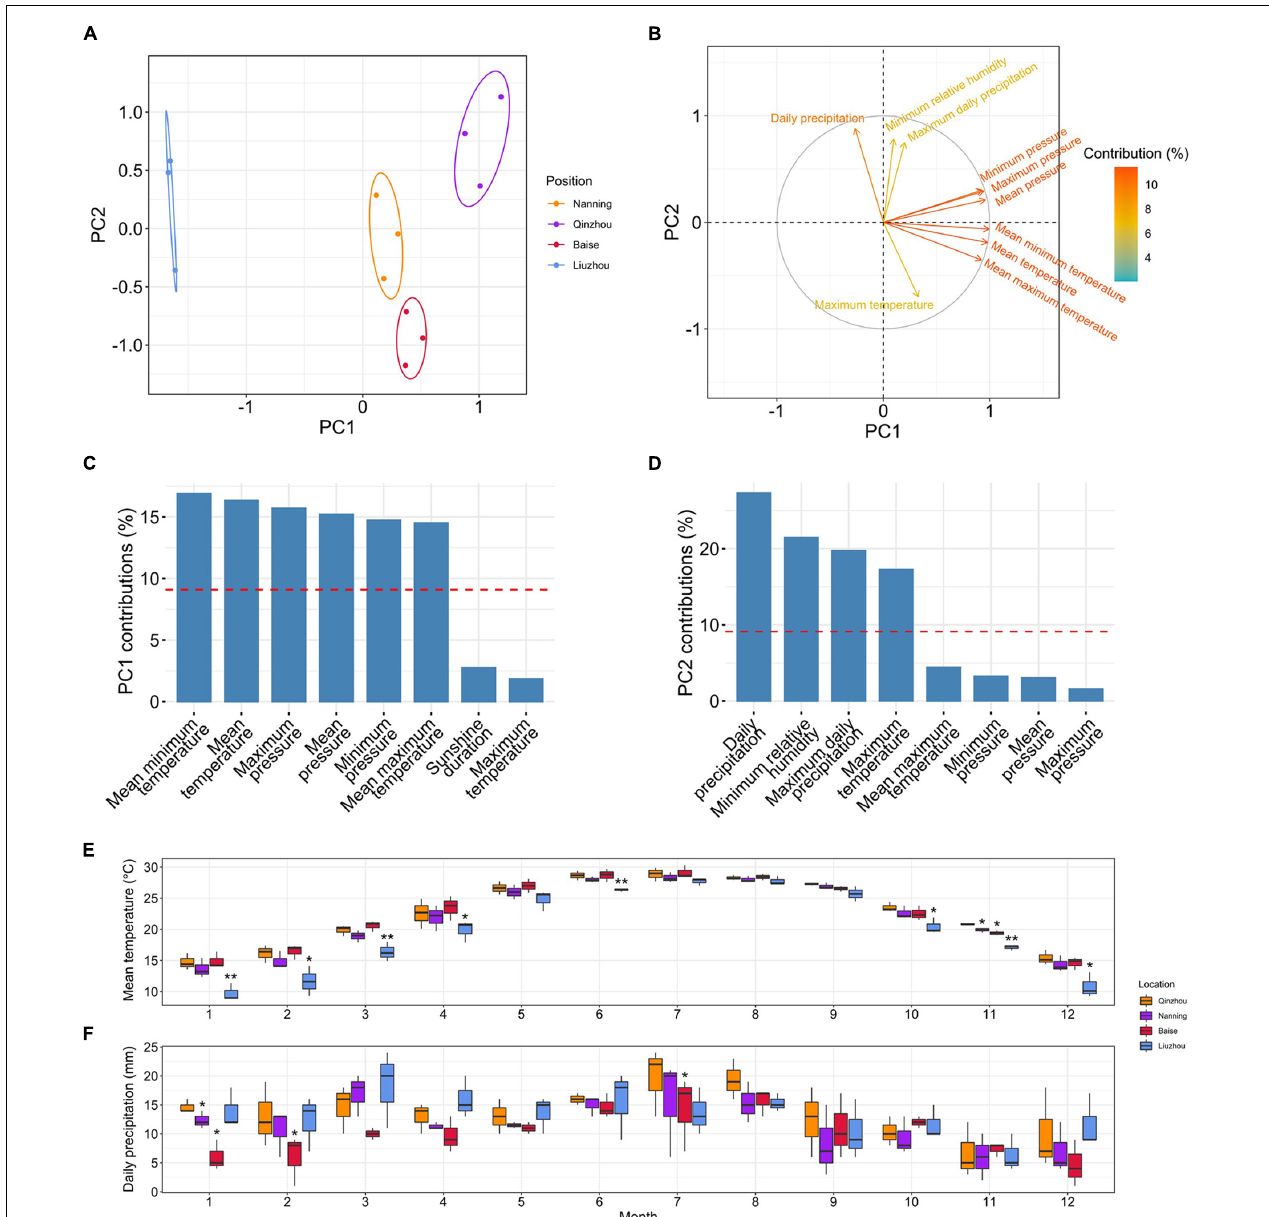
FIGURE 7 | Analyses of climatic factors in different planting locations. (A) Principal component analyses (PCA) of seventeen climatic factors in the four planting locations in 2018, 2019, and 2020. (B) The loadings of climatic factors in the PCA plot. The colors of the arrows represent the percentages of the contributions of climatic factors to the PCs. (C) Histograms of the percentages of the contributions of different climatic factors to PC1. The red dashed lines indicate the average contributions of different climatic factors. Only the top eight climatic factors are shown. (D) Histograms of the percentages of the contributions of different climatic factors to PC2. The red dashed lines indicate the average contributions of different climatic factors. Only the top eight climatic factors are shown. (E) Monthly observations of the mean temperature in the four planting locations. Single and double asterisks indicate statistically significance levels of P < 0.05 and P < 0.01, respectively, between Liuzhou and Qinzhou/Nanning (paired-sample Student’s t- test). (F) Monthly observations of daily precipitation in the four planting locations. A single asterisk indicates the statistically significance levels of P < 0.05 between Baise and Qinzhou/Nanning (paired-sample Student’s t-